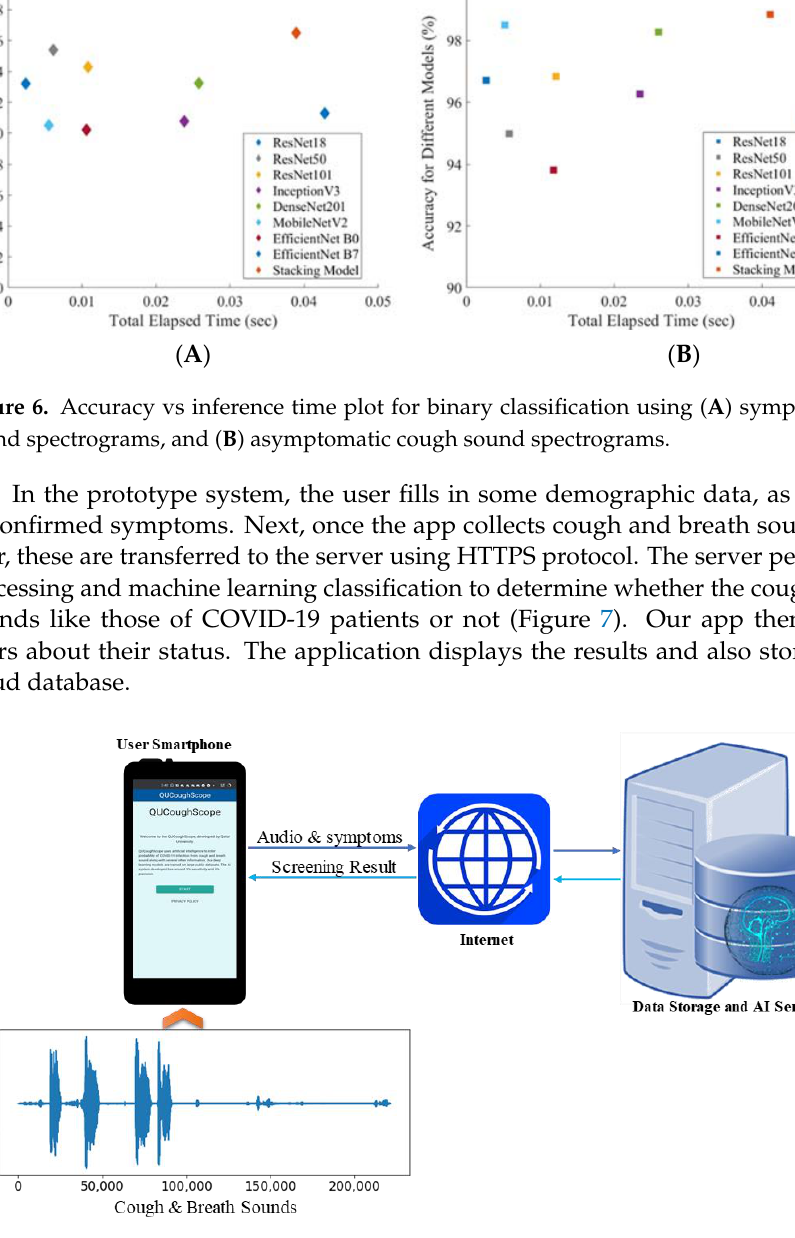
Figure 7. Illustration of a generic framework for the QUCoughScope application. Our pipeline is divided into two parts: symptomatic (cough) and asymptomatic users (no symptoms). Once the spectrogram is generated, our AI-enabled server checks whether the user has a cough or not, based on which two separate pipelines are carried out.